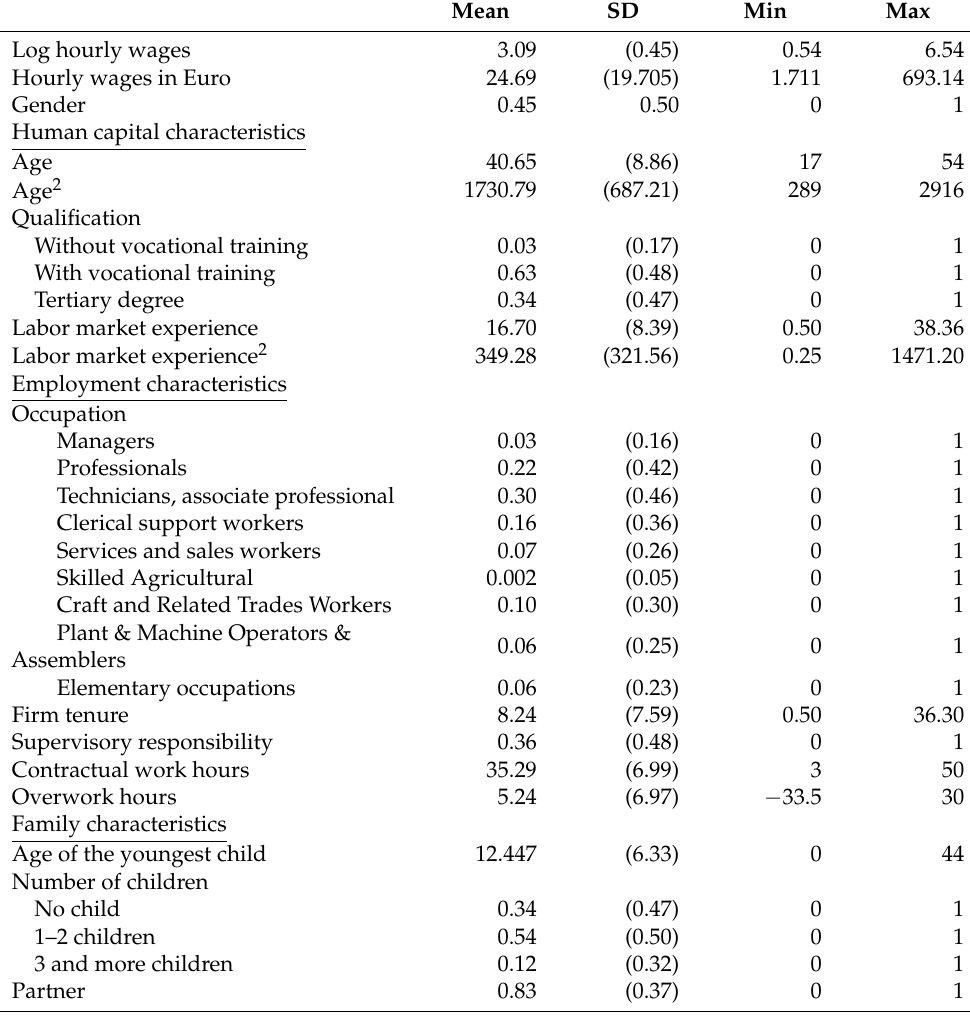
Table A1. Characteristics and distributions of the observed variables ( N =